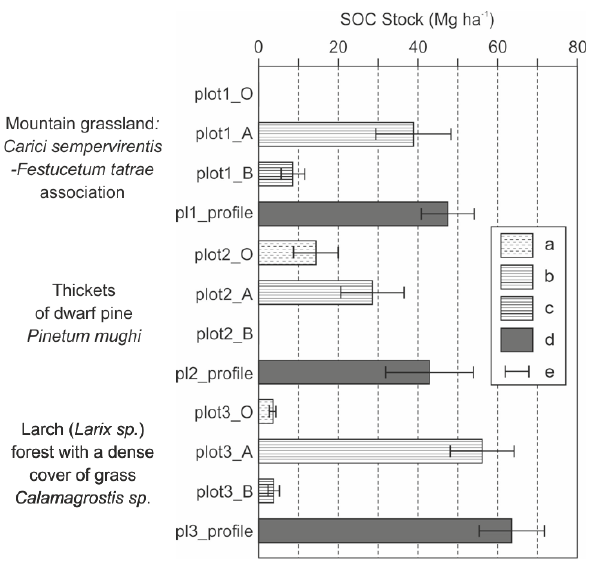
Figure 5. SOC stock for particular plots (data from 27 soil